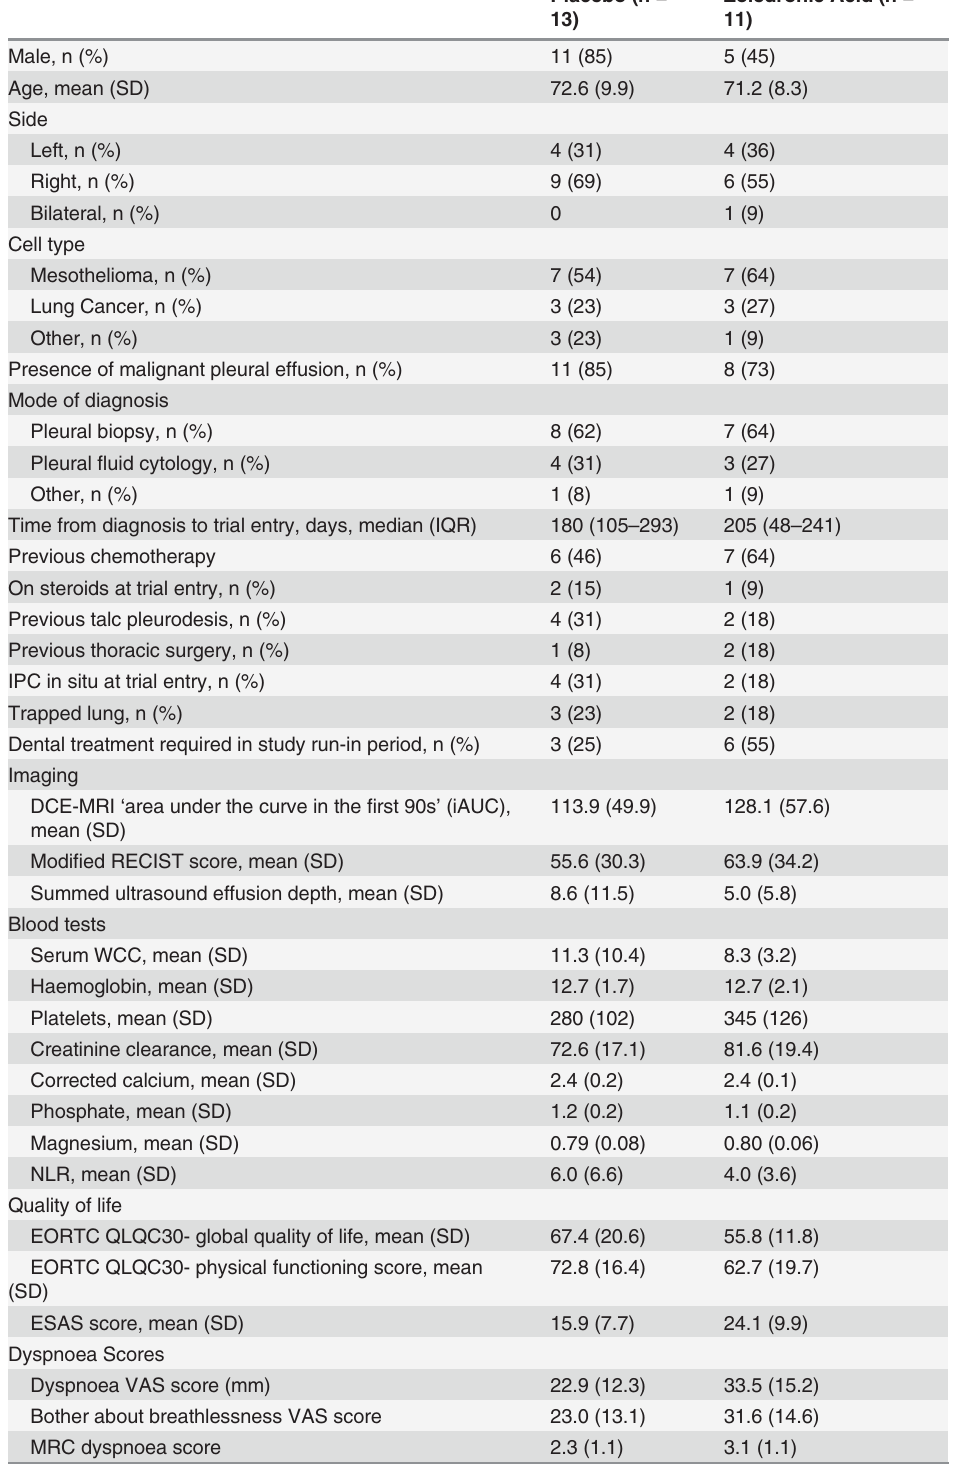
Table 1. Baseline characteristics of the randomised